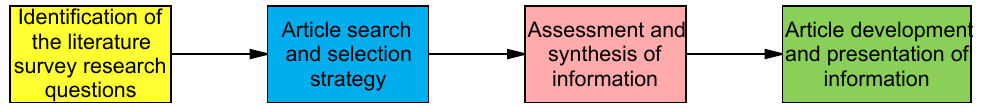
Figure 2. Methodology used in developing the literature survey presented in the present